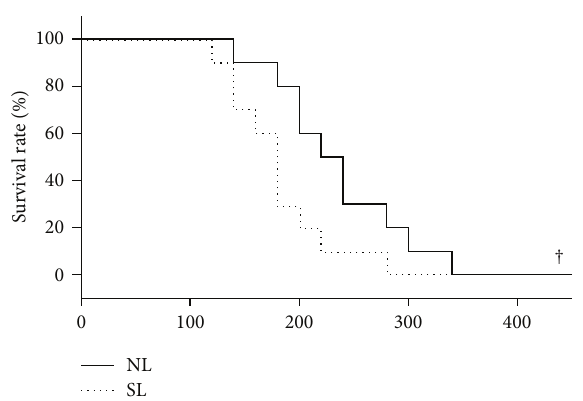
F 1: Effect of LPS administration (15mg/kg, i.v.) on the sur- vival rate of normal and diabetic rats. NL: normal rats receiving LPS administration; SL: STZ-treated rats receiving LPS administration. , Bars represent mean S.E.M of 8 rats per group. compared with the NL † 𝑃𝑃 𝑃 𝑃𝑃𝑃𝑃 ±